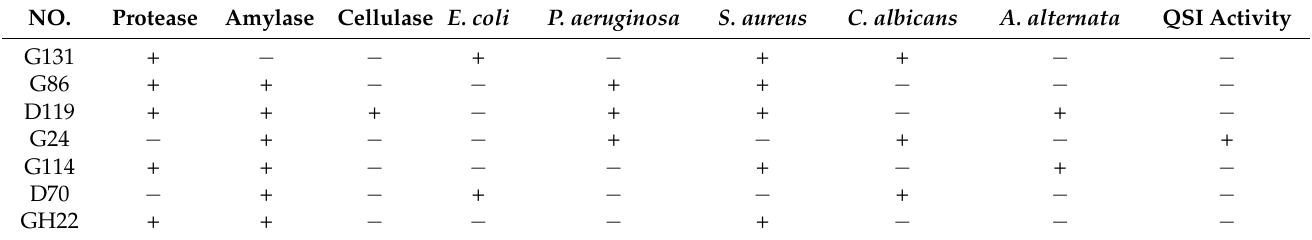
Table 7. Characteristics of the enzyme producing and antimicrobial activities and quorum sensing inhibitory activity of partial respective isolates.